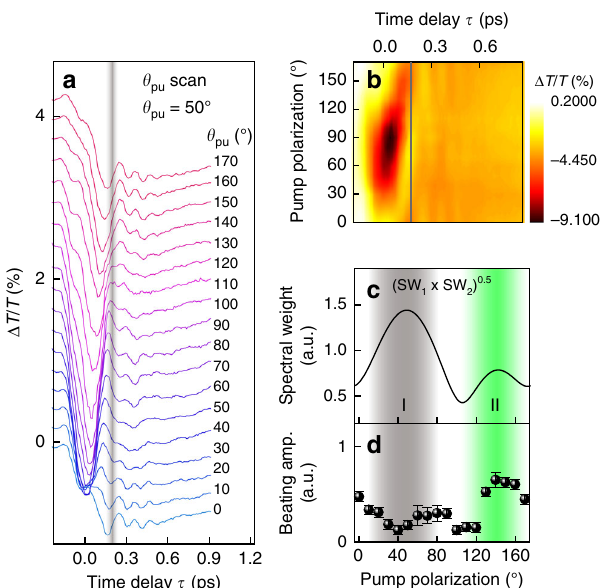
Fig. 4 Pump-polarization-dependent quantum beats. a , b θ pu -resolved DT with offset ( a ) and its contour plot ( b ). θ pr is set at 50°. Analyses are performed on the right side of the vertical gray line. c , d Comparison of beating amplitude obtained from theory ( c ) and experiments ( d ). In c , the square root of the product of the excitons ’ spectral weights is shown, which is theoretically proportional to the beating amplitude (see Supplementary Note 3). Gray (green) area represents the region I (II). The error bars represent 95% con fi dence intervals for the fi tting